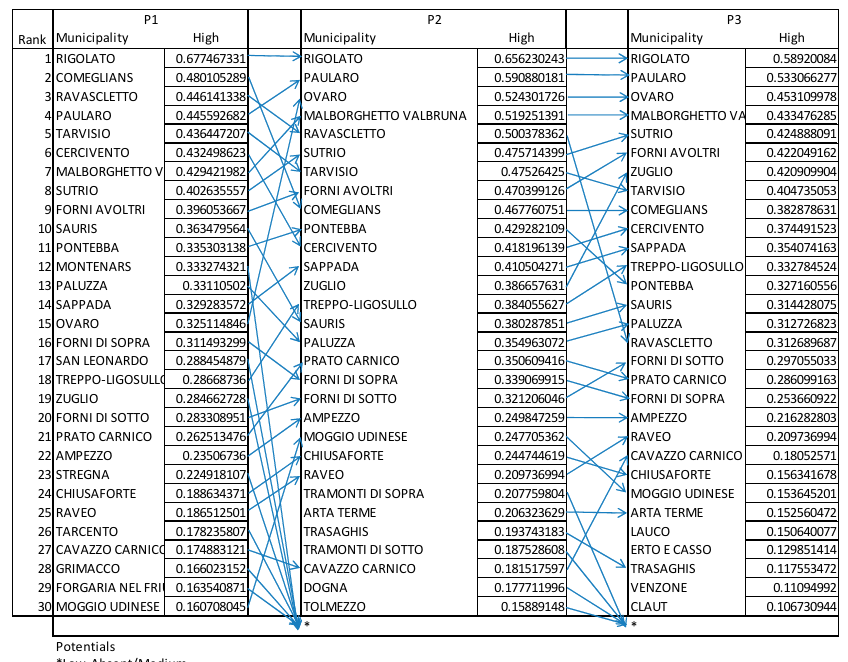
Figure A3. Forest types by increasing altitude. Average P3 value: 0.087064. Below-average = 0; Above-average = 1. Source: authors. Appendix A5. Internal Consistency of Information Supplied by Models P1, P2 and P3. Best 30 municipalities.